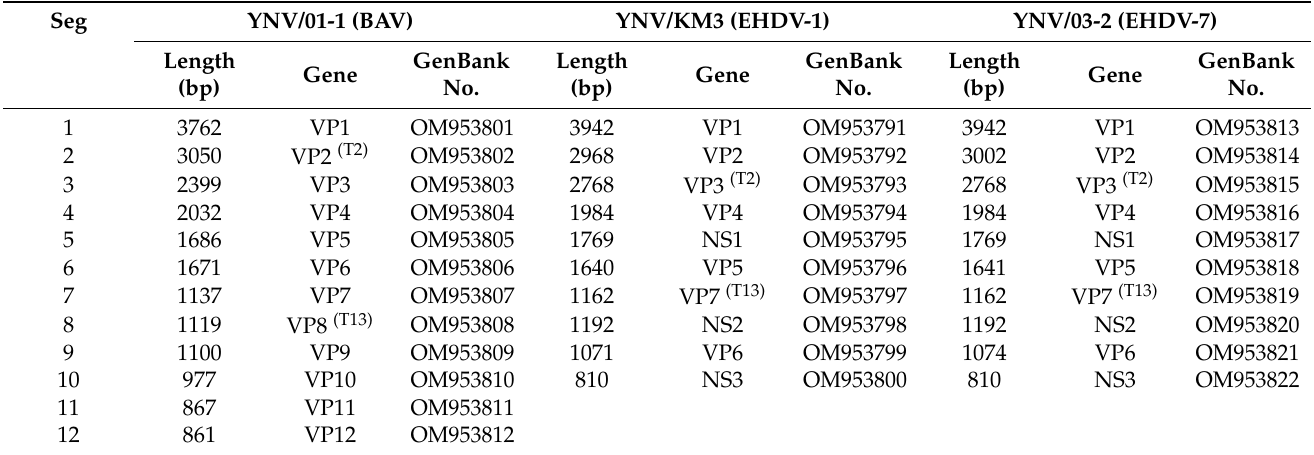
Table 2. Genomic segment lengths and Genbank accession numbers of three viruses isolated from Culicoides spp. in Yunnan Province, China.